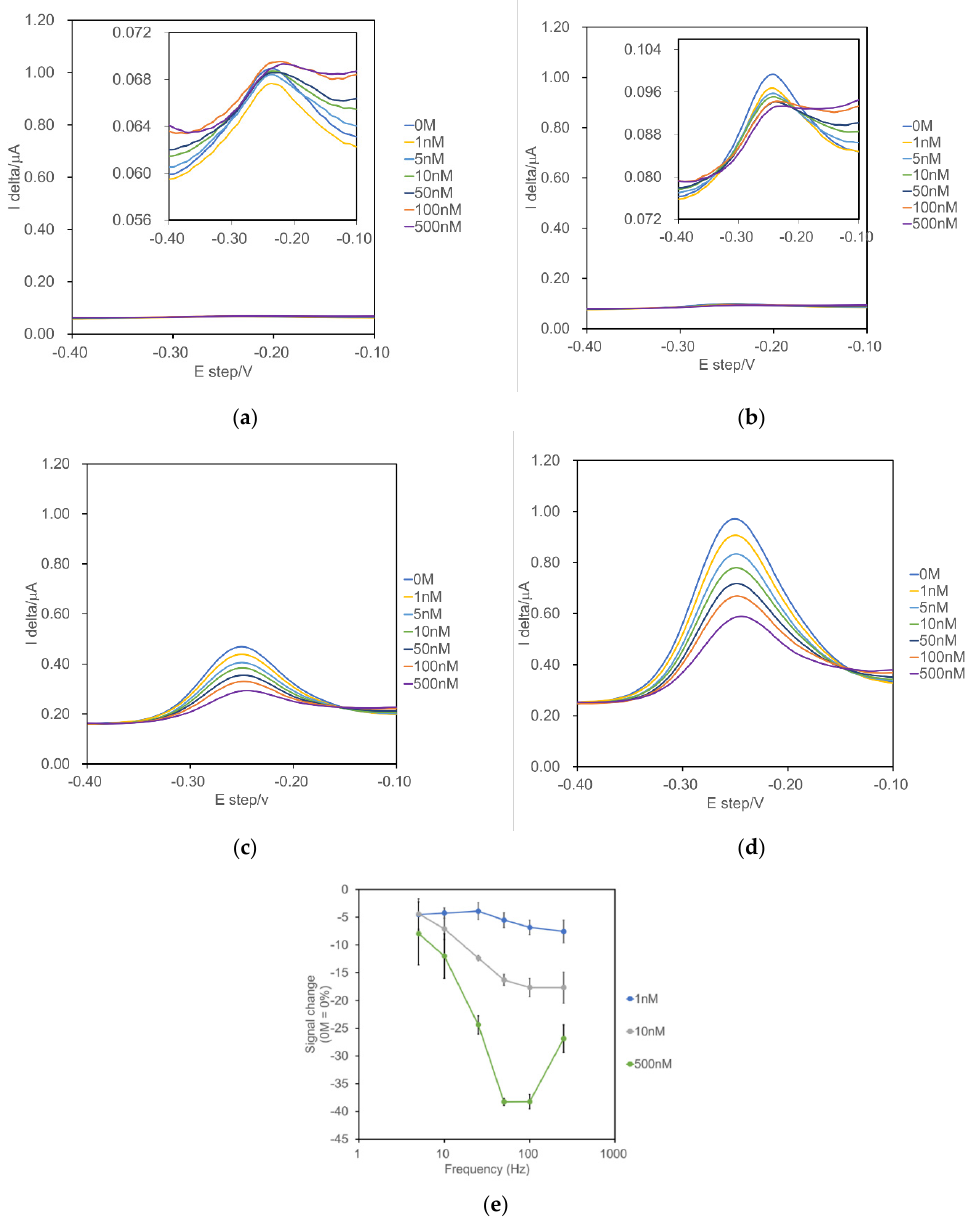
Figure 2. Representative square-wave voltammograms of fabricated arPES-modified thrombin aptamer immobilized electrodes at ( a ) 5 Hz, ( b ) 10 Hz, ( c ) 50 Hz, and ( d ) 100 Hz, and peak current change dependencies on frequency at each thrombin concentration ( e ). Square-wave voltammetry (SWV) scans were conducted as following conditions: − 0.4 to − 0.1 V, 25 mV amplitude. Seven concentrations of thrombin were used: 0, 1, 5, 10, 50, 100, and 500 nM. Insets in ( a , b ) show enlarged